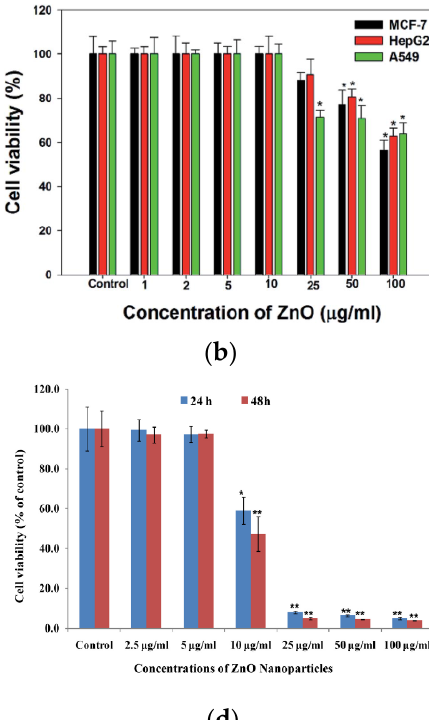
Figure 26. The mRNA expression levels of apoptotic markers in HepG2 cells treated with ZnO NPs at a dose of 50 µg/mL for 24 h. The data are presented as mean ± standard deviation of three identical experiments with three replicates. Reproduced from [150] with permission of Elsevier. In other cancer cell lines, ZnO spherical particles (26 nm) and ZnO nanorods (62 and 90 nm) induced size-, dose-, and time-dependent cytotoxicity in human colon carcinoma (Caco-2) cells. These led to the generation of ROS and oxidative stress, and LDH leakage accordingly [149]. A recent study by Liu et al. showed that commercial ZnO NPs of different sizes (average size of 18.5 nm and 47.1 nm) would induce neurotoxicity in human neuroblastoma SHSY5Y cells in a size- and time-dependent manner [154]. The cells were treated with ZnO NPs at 5, 10, 20, 40, 60, 80, and 100 µg/mL for 2, 6, 12, and 24 h. Toxic effects were more significant at concentrations ≥ 20 μg/mL, especially for the cells exposed to smaller ZnO NPs (18.5 nm) for time periods ≥ 12 h. Intracellular Zn 2+ ions due to the dissolution of ZnO NPs in lysosome induced the generation of ROS and oxidative stress, leading to mitochondria dysfunction, cytoskeletal disruption, and apoptosis. Wang et al. observed a decline in the viability of mouse glioblastoma and neuroblastoma cell line by treating with ZnO nanowire arrays [155]. From the literature, ZnO NPs (20 nm) with doses of 5, 10, 20, and 30 µg/mL induced dose- and time-dependent toxicity in human ovarian cancer cells (SKOV3). Apoptosis appeared at doses ≥ 20 μg/mL through the generation of ROS, reduction of MMP, upregulation of p53, LC3, Bax, caspase 9, and downregulation of Bcl2 [156]. Reshma and Mohanan reported that spherical ZnO NPs (25–40 nm) with doses of 5, 15, 25, 50, 75, and 100 µg/mL induced toxicity in human embryonic kidney (HEK 293) cells in dose and time dependent manner. This was attributed to the formation of ROS and the induction of oxidative stress,